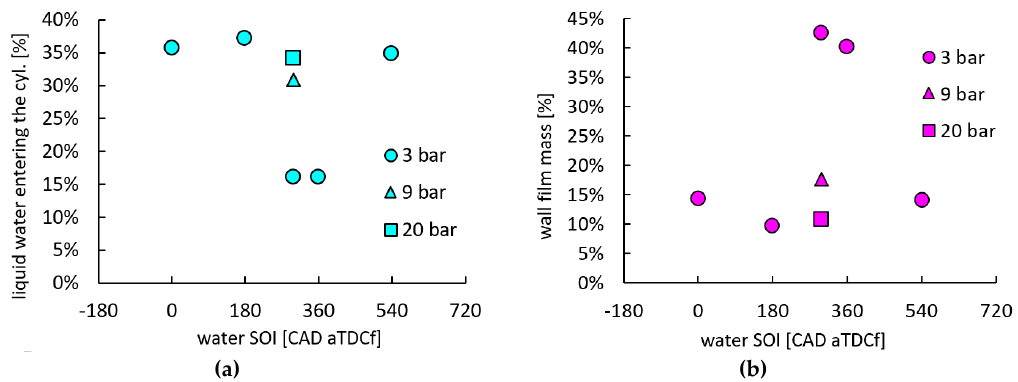
Figure 9. Liquid water balance in the ports and runner. Percentages refer to the injected water mass: ( a ) liquid water entering the cylinder; ( b ) wall film mass.